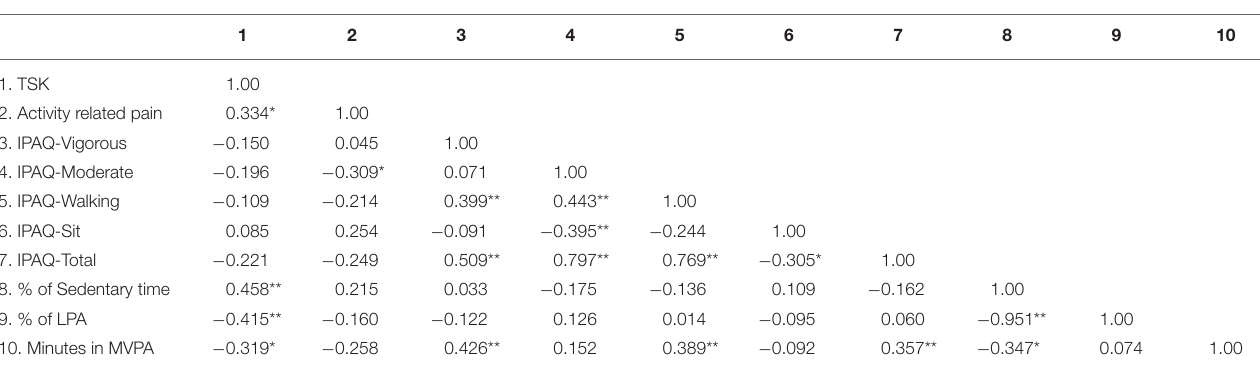
TABLE 3 | Bivariate correlation matrix between TSK, activity-related pain, and the physical activity